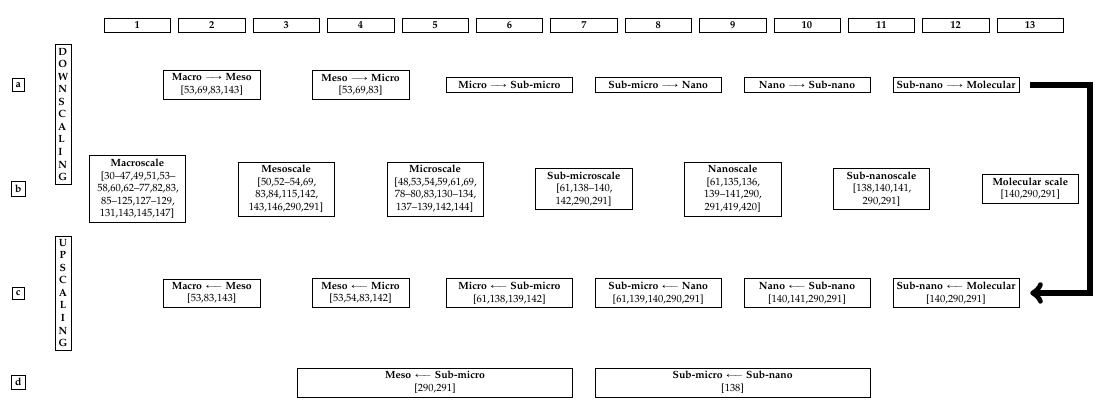
Table 3. Bone multiscale